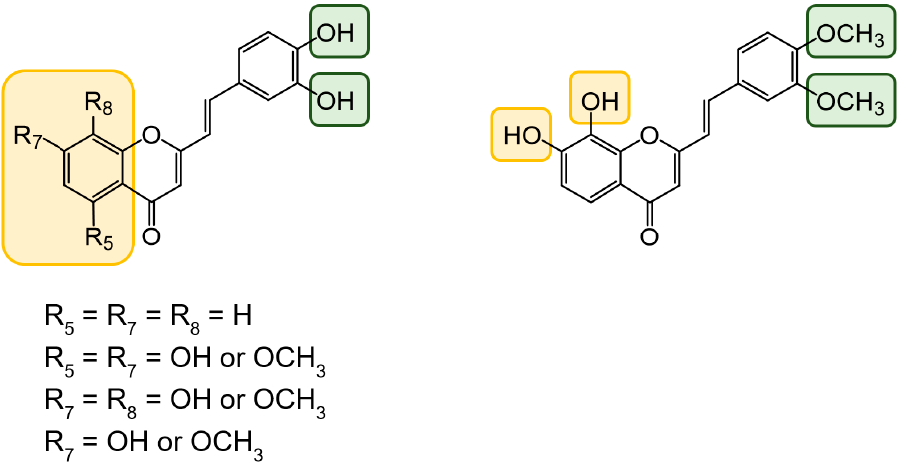
Figure 7. Chemical structures of the most active 2-SC in the modulation of neutrophils’ oxidative burst.